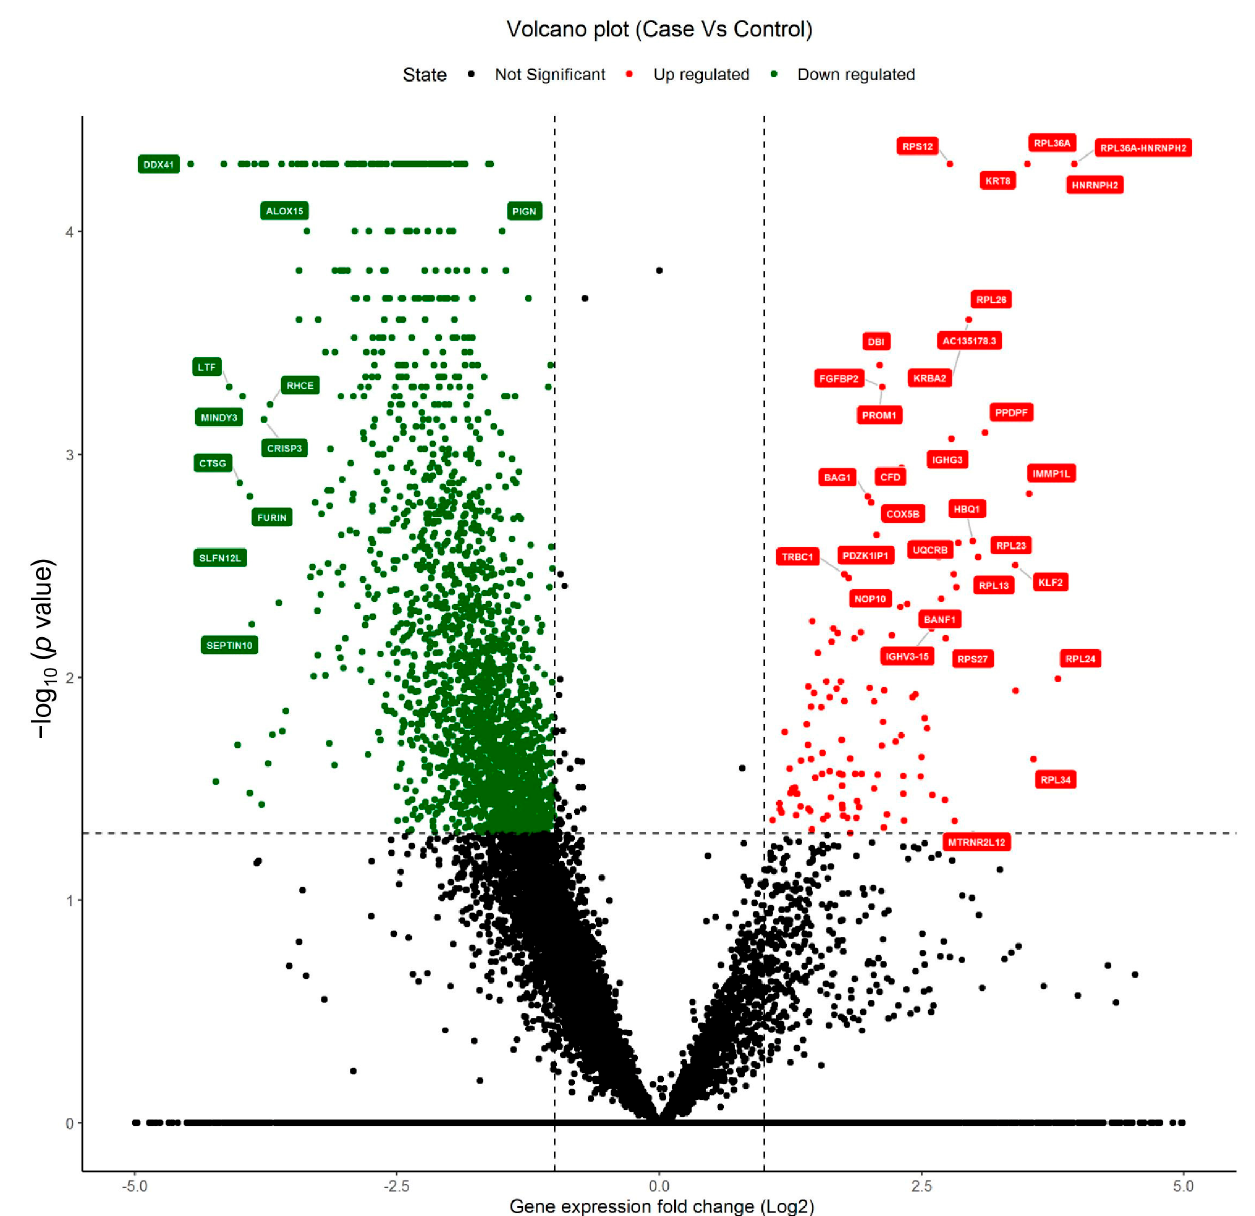
Figure 3. Volcano plots of the significantly upregulated genes (red colored) and downregulated genes (green colored) between autism and controls. Upregulated: foldchange ≥ 0.8 and p -value ≤ 0.05; downregulated: foldchange ≤ − 0.8 and p -value ≤ 0.05.